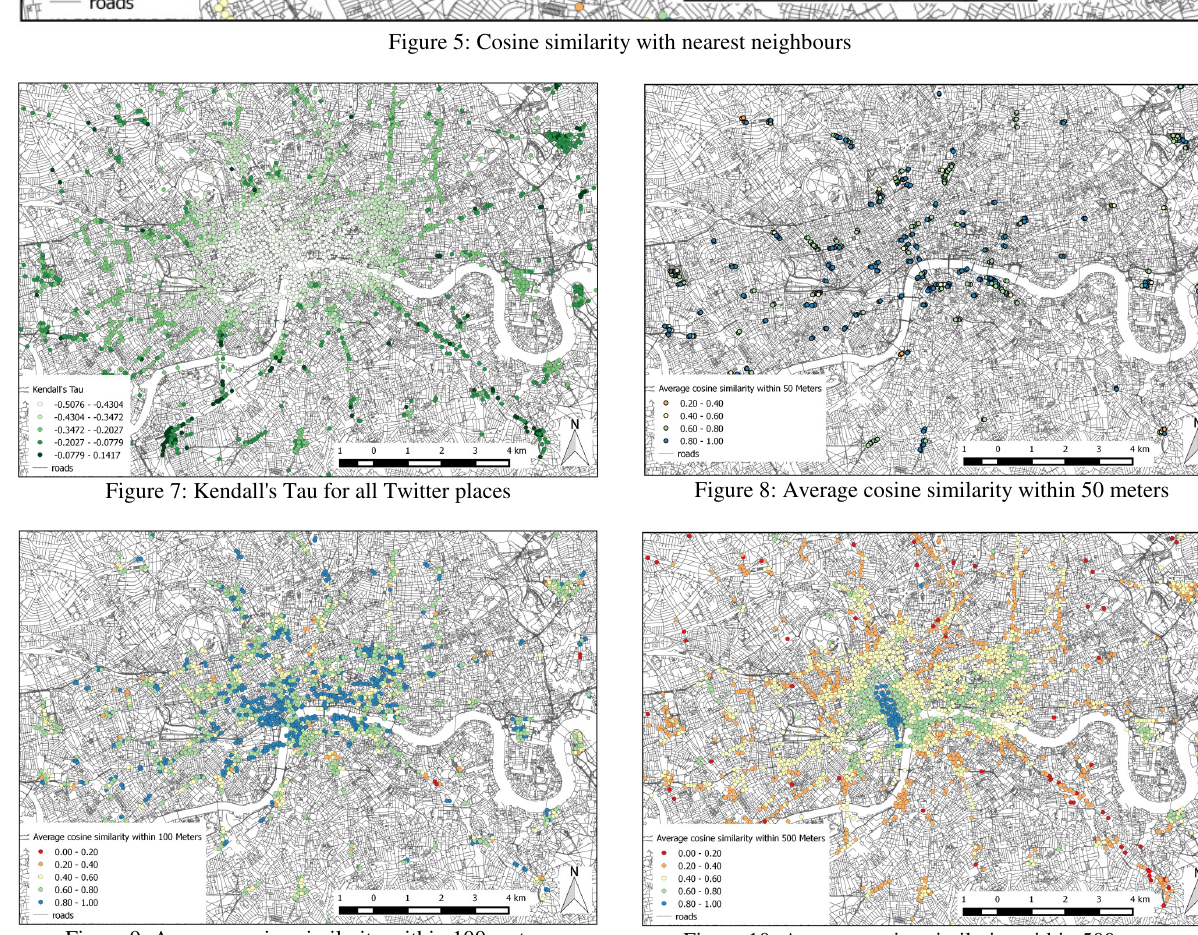
Figure 10: Average cosine similarity within 500